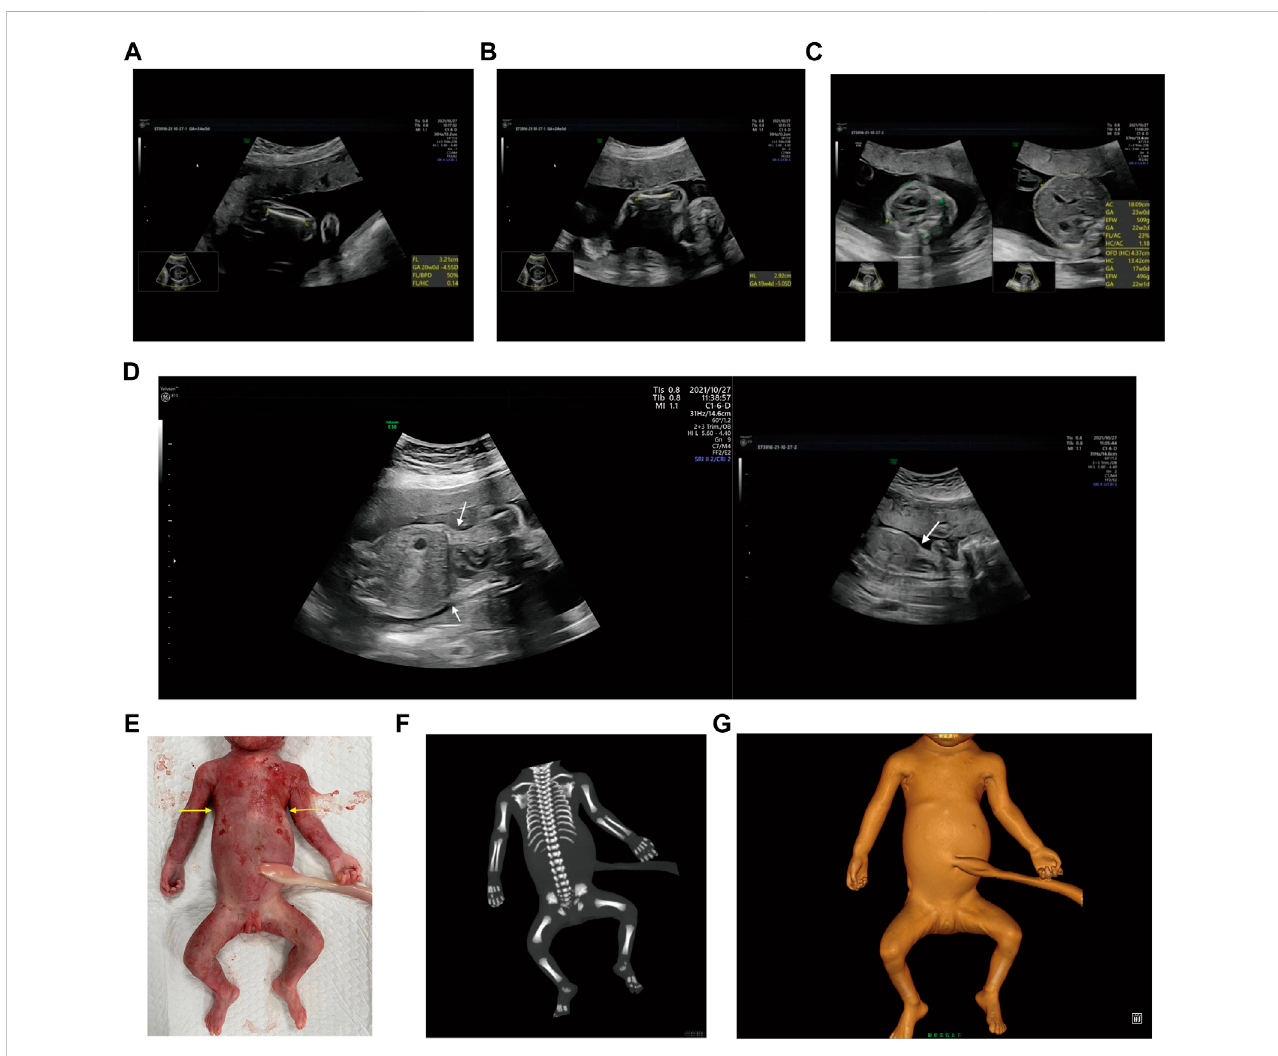
FIGURE 1 Antenatal ultrasound, photos and radiographs of the foetus 1 (A) The femur length was 3.2 cm. (B) The humerus length was 2.9 cm. (C) The thoracic circumference and abdominal circumference was 13.4 and 18.1 cm respectively. (D) Sagittal view of fetal thorax and abdomen showed a “ thoracoabdominal notch ” inthejunctionofthoraxandabdomen(indicatedbythearrows). (E) Appearanceofthefoetusafterinducedlabor.Anarrowthoraxwasobserved. (F,G) Radiographs and CT 3-dimensional image reconstruction of the foetus. A narrow thorax and short long bones were